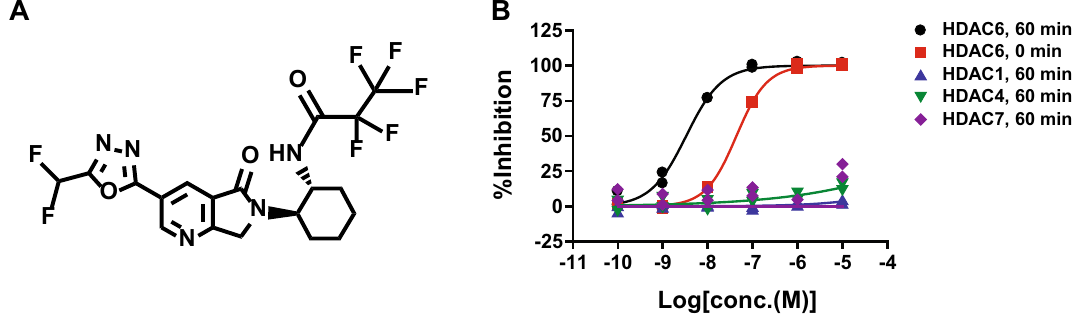
Figure 1. Chemical structure of T-518 and enzyme inhibition curve for HDAC6, 1, 4, and